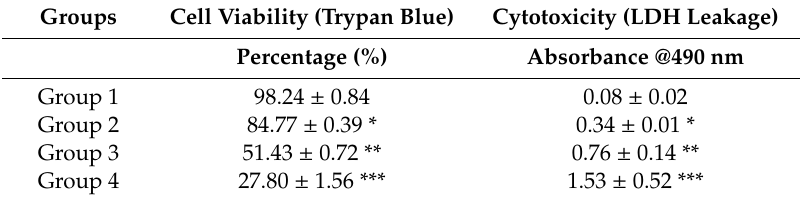
Table 1. E ff ect of CA in PDT on percentage cell viability and cytotoxicity of lung cancer cells.